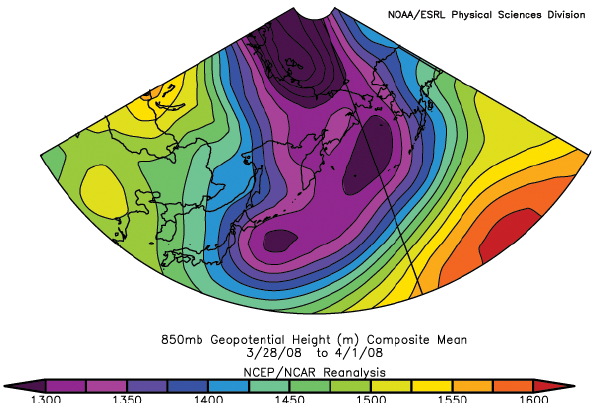
Fig. 12. Mean 850hPa geopotential height (m) pattern, 28 March– 1 April 2008. This represents rough synoptic flow paths leading up to the “Pristine” period.